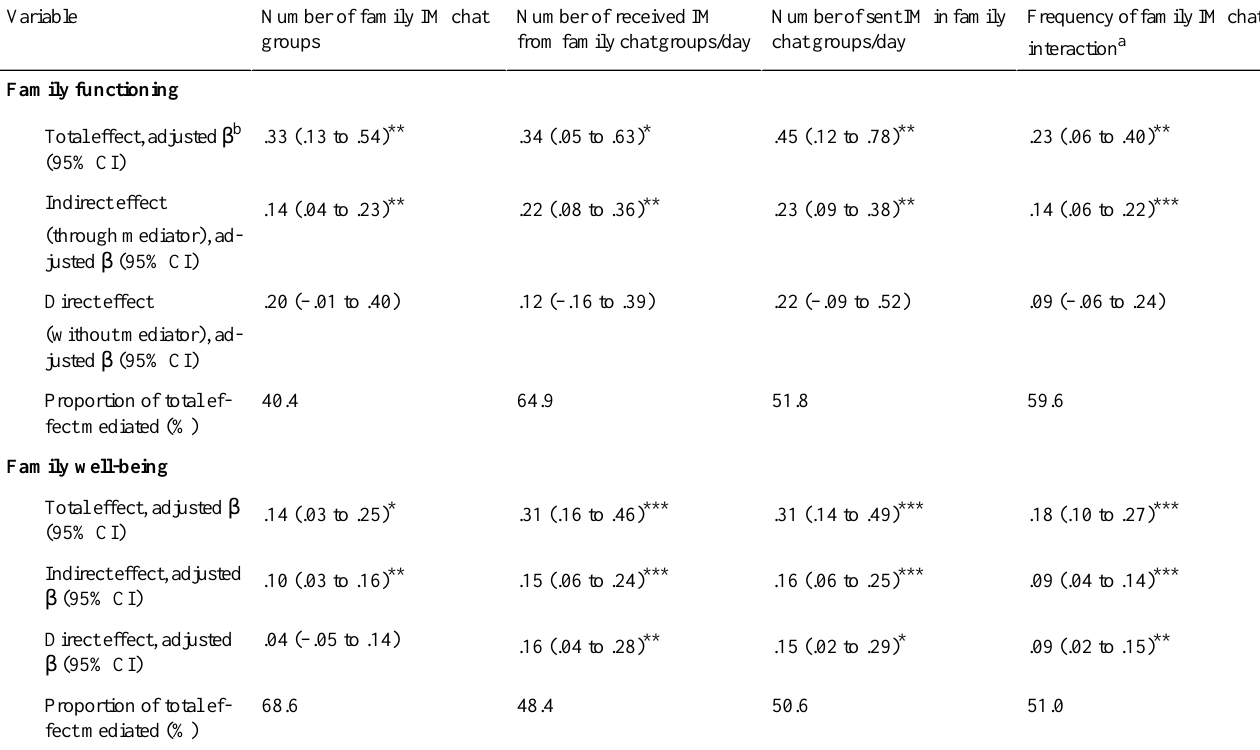
Table 3. Adjusted indirect, direct, and total effects of the number of family instant message (IM) chat groups (N=1638) and use (N=1180) on family functioning and family well-being mediated by family communication using the Sobel